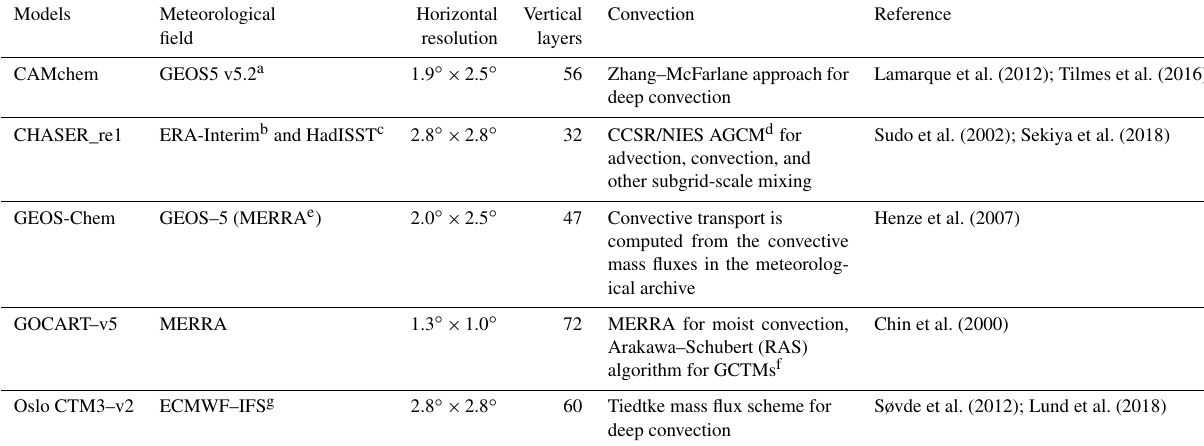
Table 2. Configurations of models used in this study.